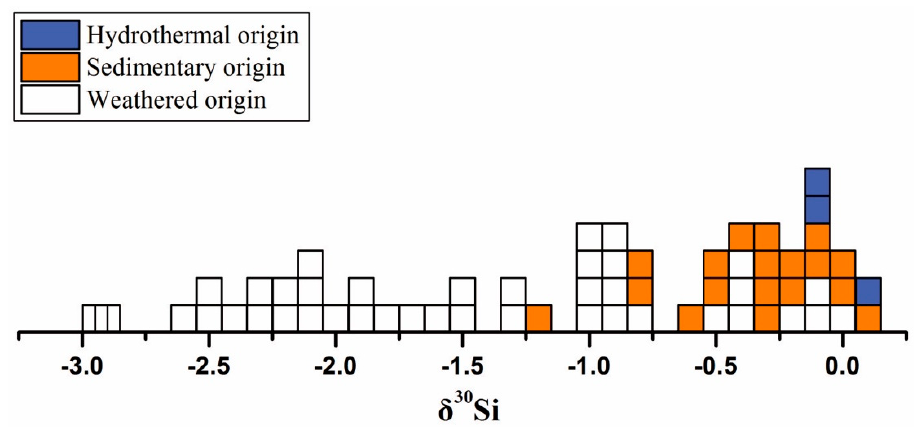
Figure 11. Distributions of δ 30 Si among various types of clay minerals (data cited from References